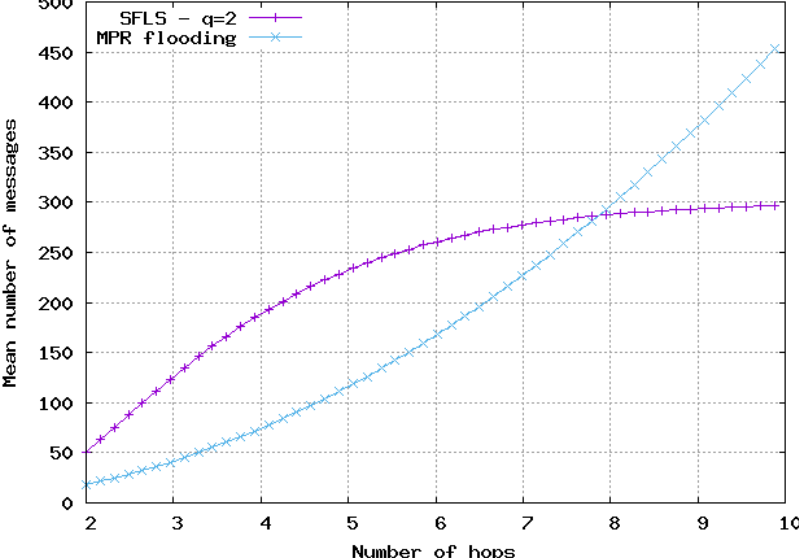
Figure 10. Mean number of messages sent for update with respect to number of hops in 2D homogeneous network, M = 100. Comparison of SFLS with the MPR